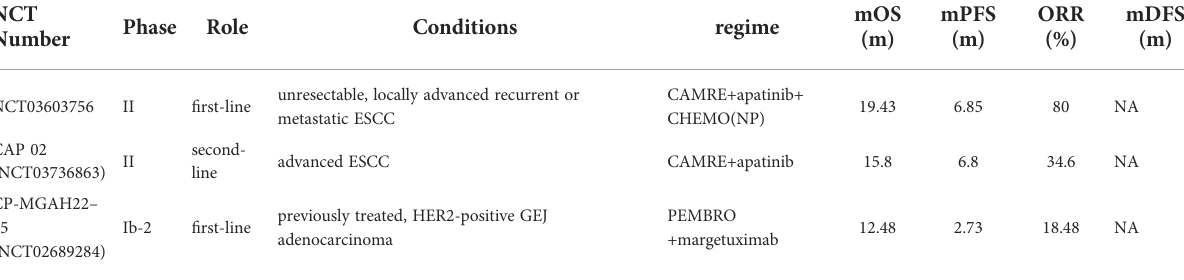
TABLE 3 Clinical Trial of Immunotherapy in Combination with Targeted Drugs.